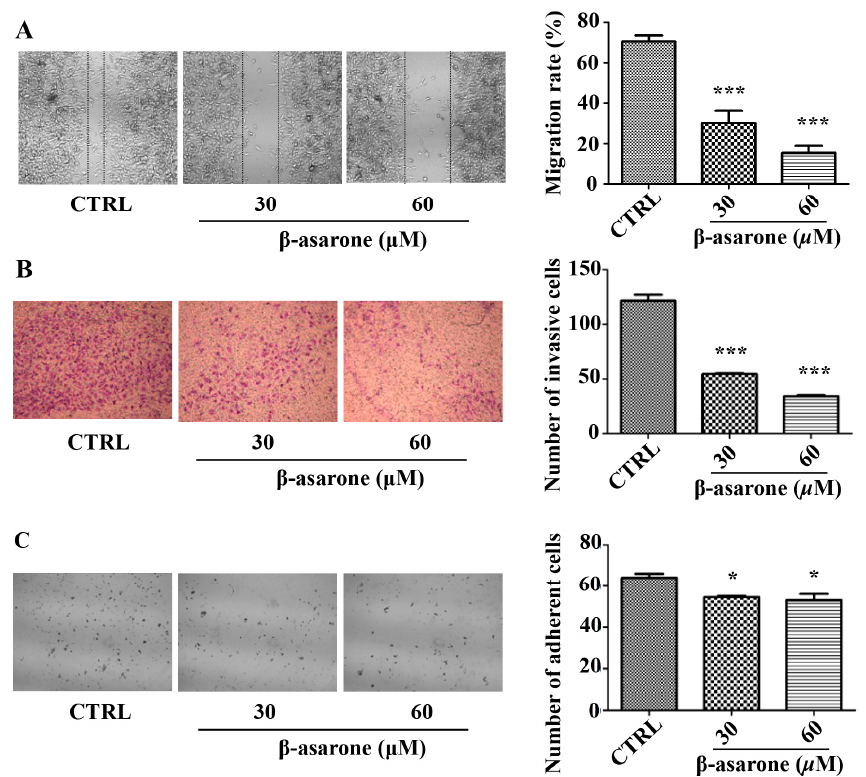
Figure 2. β -asarone suppressed the migration, invasion, and adhesion of U251 cells. ( A ) Wound healing assay. Cells were seeded on each side of an Ibidi culture insert overnight and then treated with β -asarone as indicated for 48 h, respectively. Cells were photographed following 0, 12, 24, 36, and 48 h of incubation. The representative images were captured at 48 h after treatment; ( B ) Boyden chamber invasion assay. Cells were pretreated with β -asarone as indicated for 24 h and then seeded in the chamber with coated Matrigel of a 24-transwell plate for another 24-h invasion assay; ( C ) Adhesion assay. Cells were preincubated with β -asarone as indicated for 24 h and seeded onto a 96-well plate coated with Matrigel for 4-h adhesion. Then, attached cells were stained and counted. Randomly chosen fields were obtained using an optical microscope (100× magnification). Values represent mean ± SD. * p < 0.05 and *** p < 0.001 compared with vehicle.